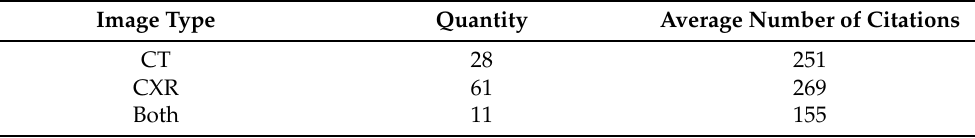
Table 4. CXR vs. CT